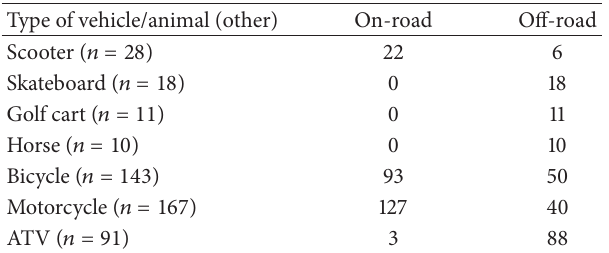
Table 1: Classification of vehicles as on- or off-road, per injury e code matrix.